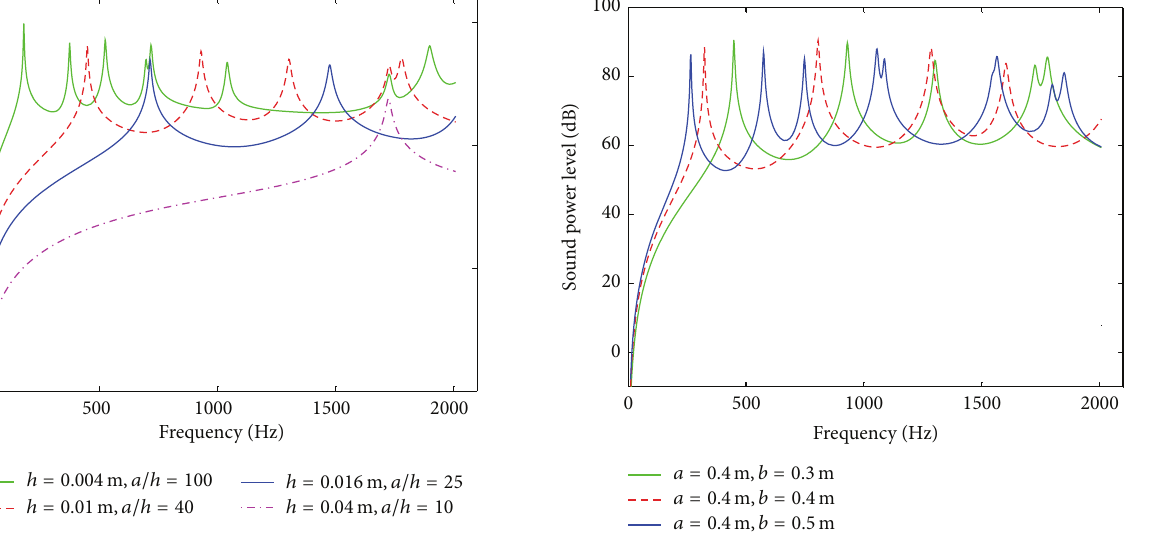
Figure 12: The effect of aspect ratio on sound radiation of FGM plates.